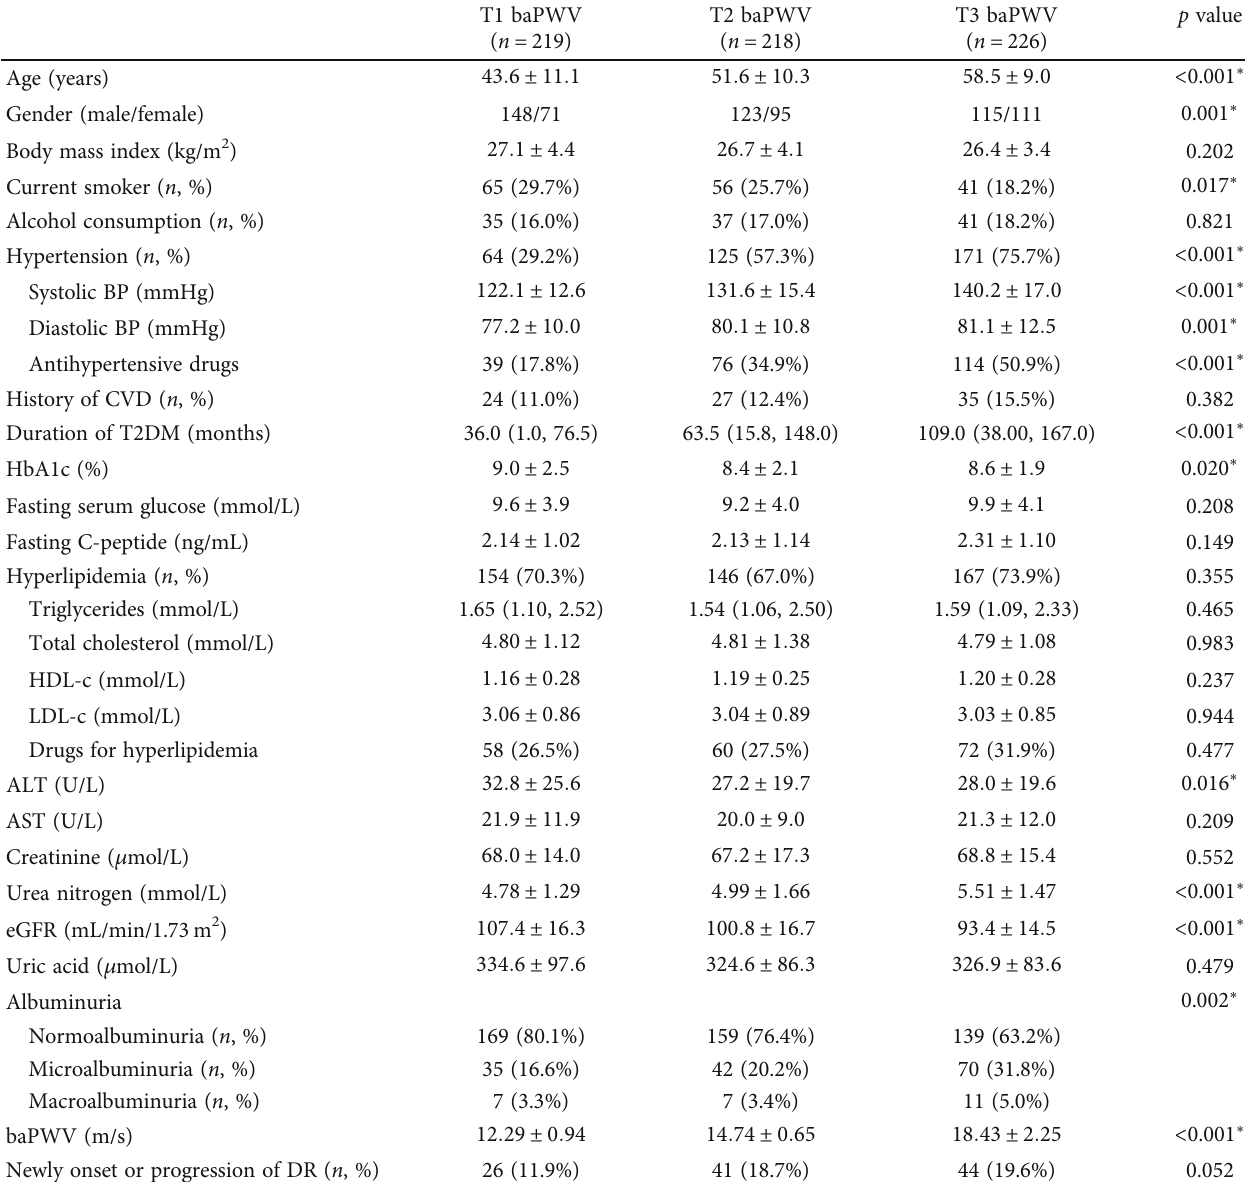
Table 2: Clinical characteristics of patients in the follow-up analysis divided by tertiles of baPWV. T1 baPWV T2 baPWV T3